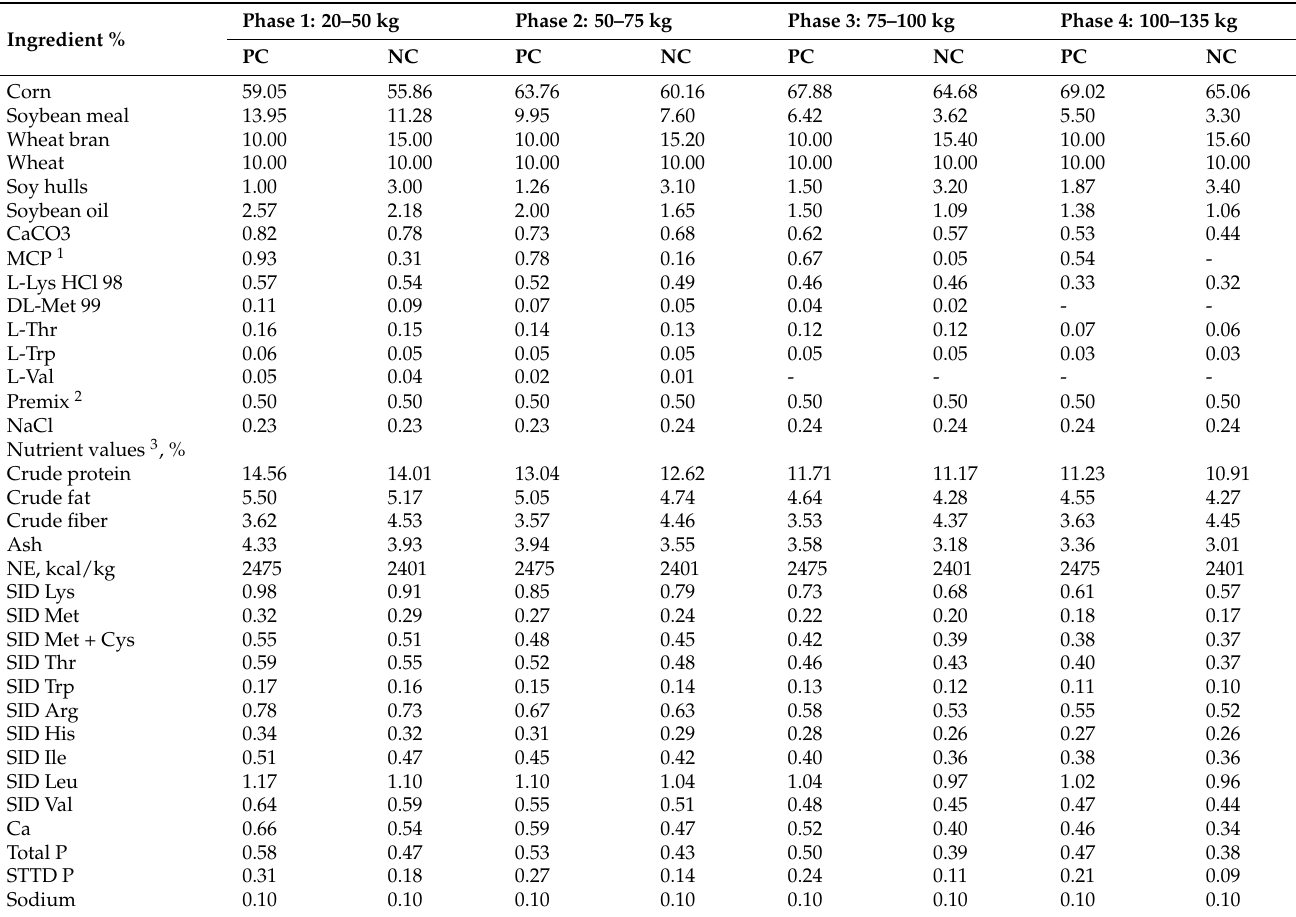
Table 1. Composition and nutritional values of the